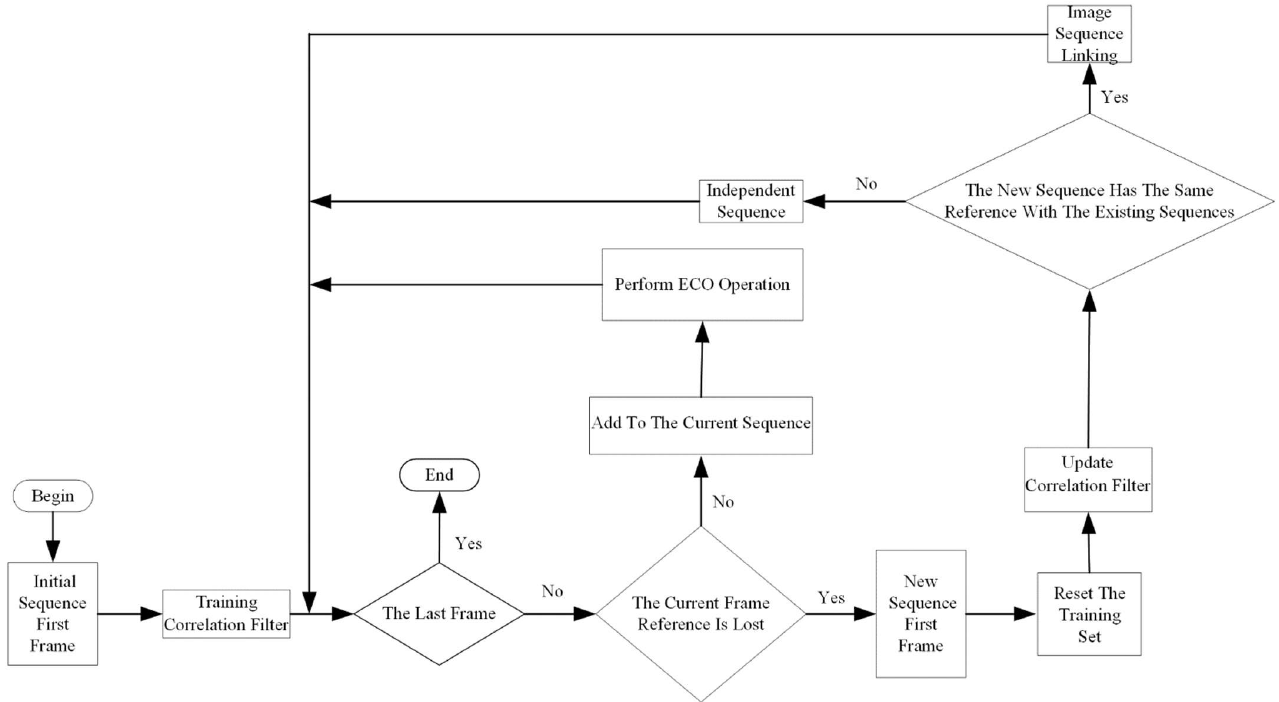
Figure 2. Update efficient convolution operators for imaging stabilization (UECO) flowchart. UECO trains the initial correlation filter with the initial image sequence. When the reference is lost, UECO resets the training set and starts a new process, taking the current frame as the first frame of the sequence. Finally, by image sequence linking, UECO links image sequences with the same reference together.